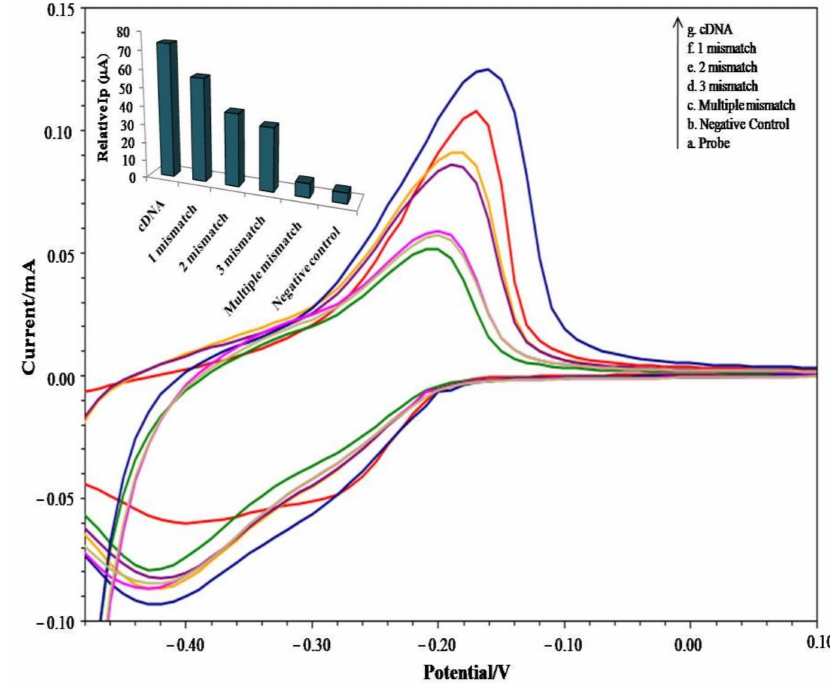
Figure 5. Cyclic voltametric analysis of DNA sensor selectivity using cDNA (complementary DNA) and a sequence with different numbers of mismatched bases. The insert shows the relative peak current values % Ip (with respect to the probe) of the DNA sensor with cDNA and different numbers of mismatched